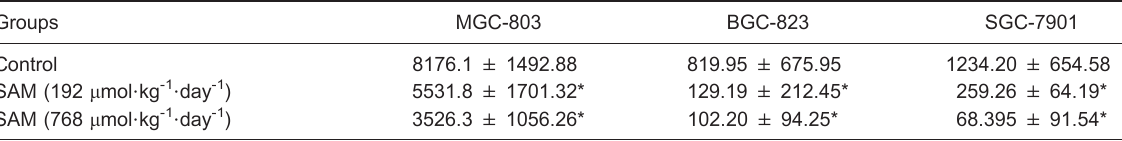
Table 2. Effect of S-adenosylmethionine (SAM) treatment on tumor volume in nude mice. Groups